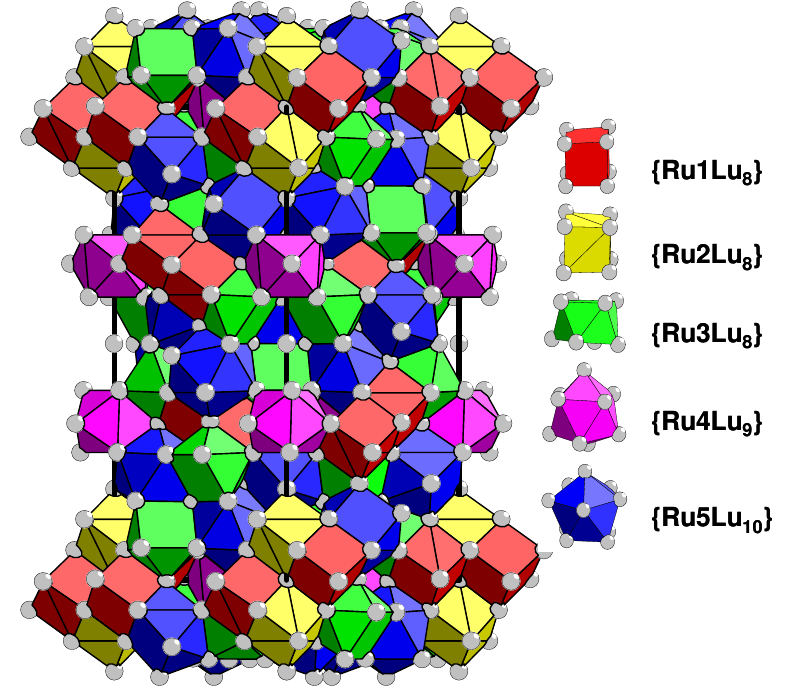
Table 1. Ru−Lu and Ru−Ru distances in the crystal structure of {Ru